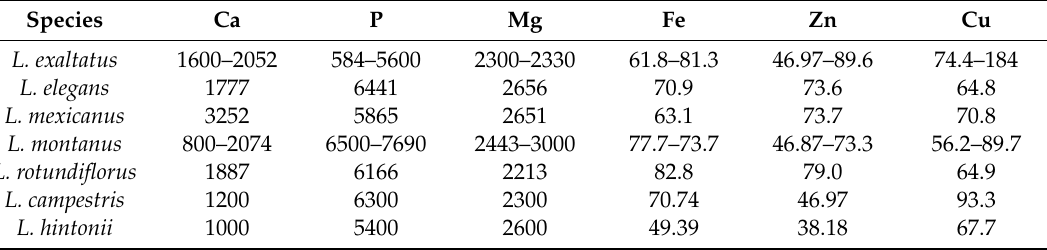
Table 12. Mineral content in wild lupine seeds (mg / kg in dry